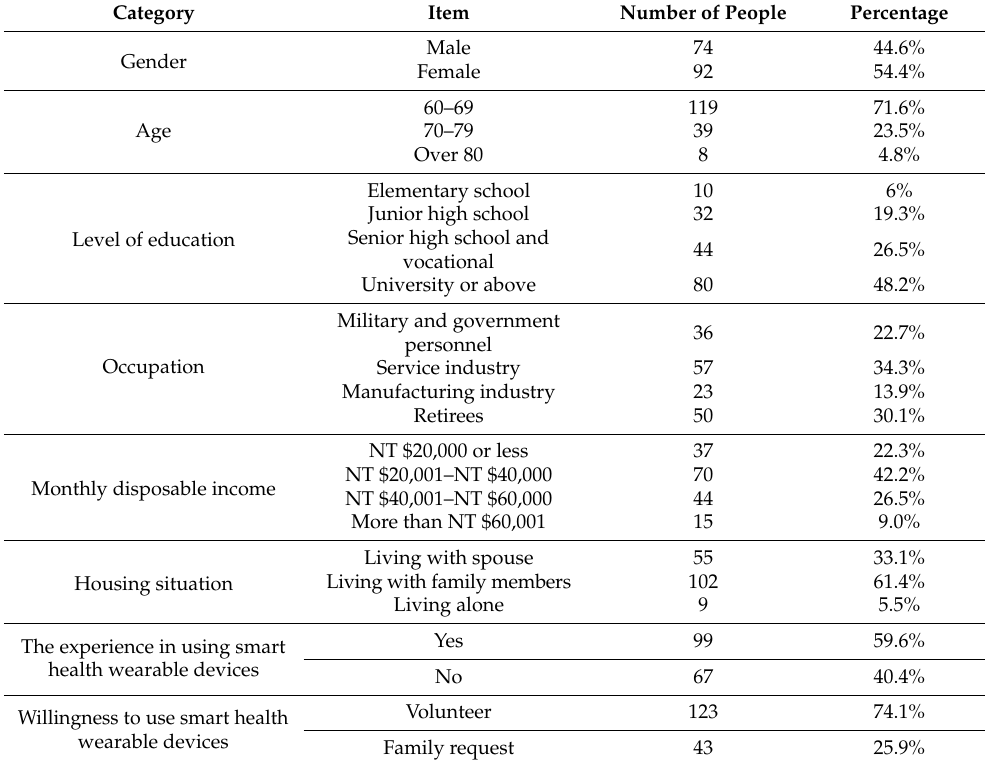
Table 2. Description of the interview sample.